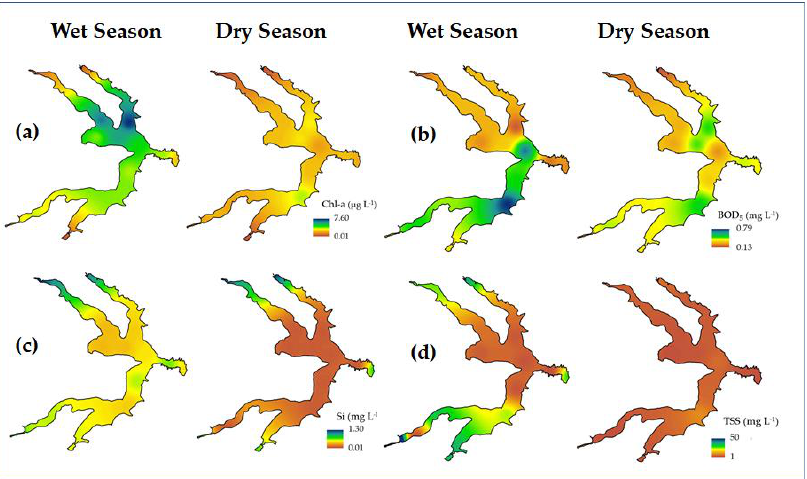
Figure 12. Spatial distribution of water quality variables: ( a ) Chl-a, ( b ) BOD 5 , ( c ) Si and, ( d ) TSS for wet and dry season. wet and dry